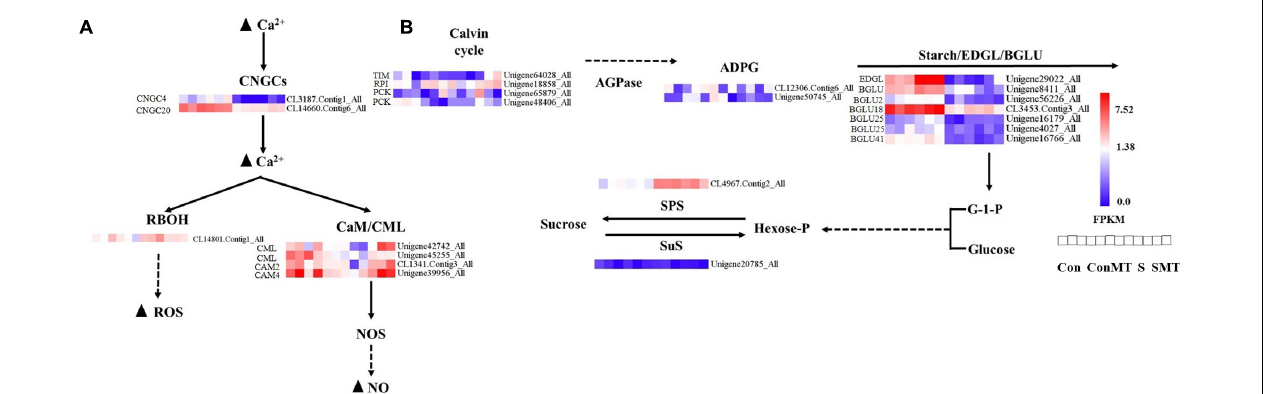
FIGURE 6 | Differentially expressed genes caused by heat stress. (A) Calcium signal transduction. (B) The metabolism of starch and sugars. The bar represents the expression (FPKM) of each gene in Con, ConMT, S, SMT as indicated by blue, white, and red squares. Blue and red represent low and high expression, respectively. Con, control; S, heat stress; SMT, heat stress with exogenous melatonin treatment; ConMT, control with exogenous melatonin treatment. More detailed information is shown in Supplementary Table 12